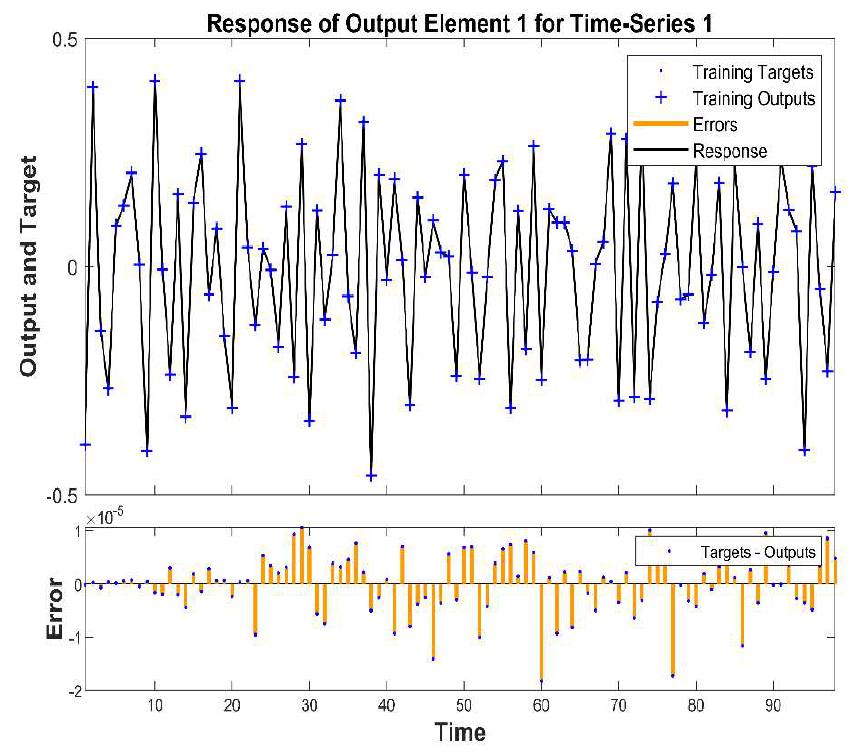
Figure 9. The responses of the target and output time series are based on training process.